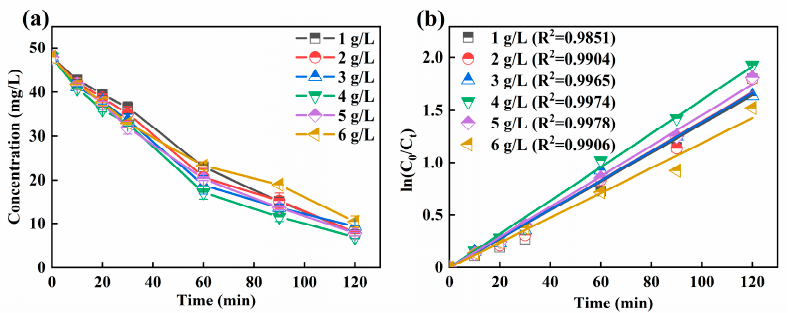
Figure 4. Decomplexation of Ni-EDTA in different particle electrode dosages ( a ) and kinetics fitting lines ( b ).